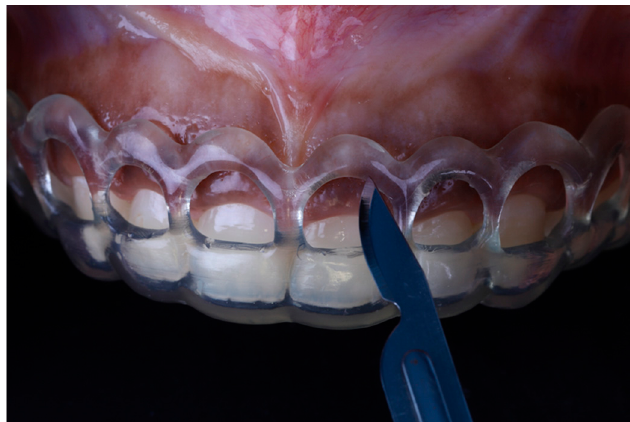
Appl. Sci. 2020 , 10 , x FOR PEER REVIEW Figure 5. Surgical incision based on the guide. Figure 5. Surgical incision based on the guide. Figure 5. Surgical incision based on the guide.